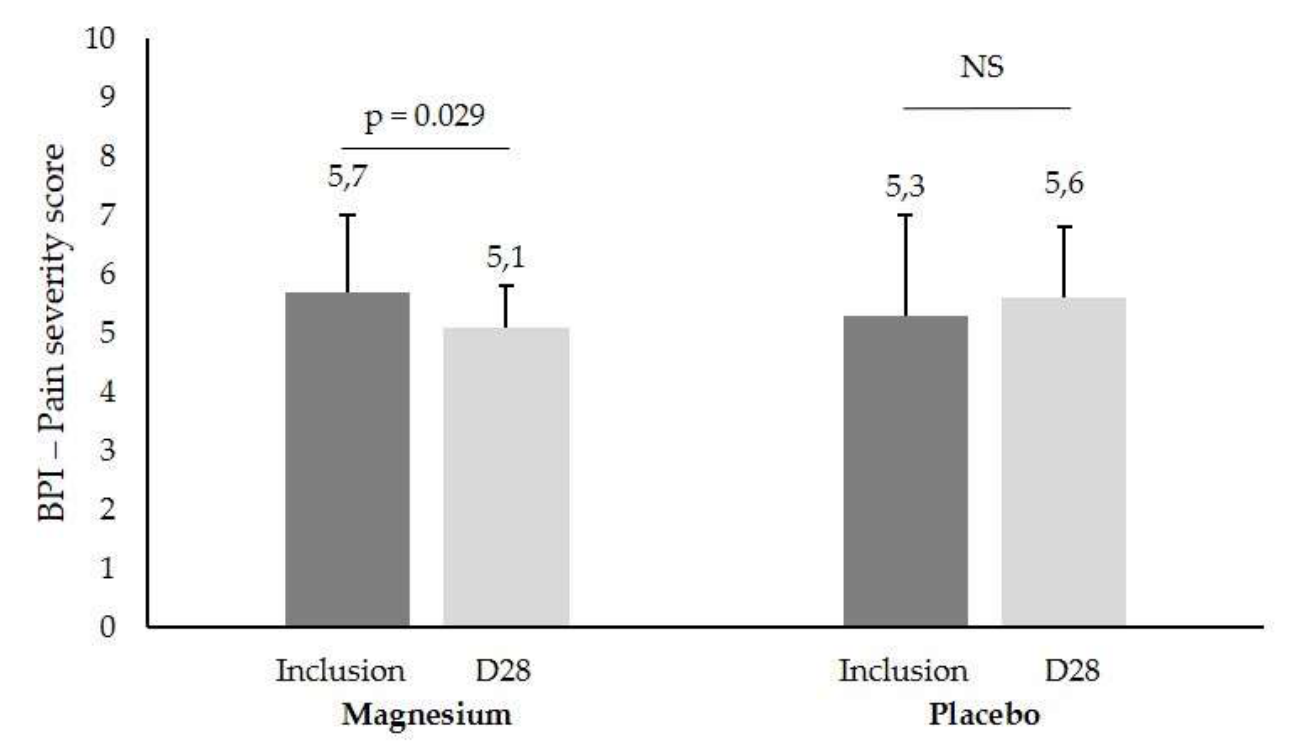
Figure 3. BPI ‘pain severity’ score (mean ± SD) in patients with a mild/moderate (m/M) stress score at inclusion and after one month of Mg or placebo treatment (D28), NS, not significant. Table 2. m/M and S/S+ subgroup parameters.